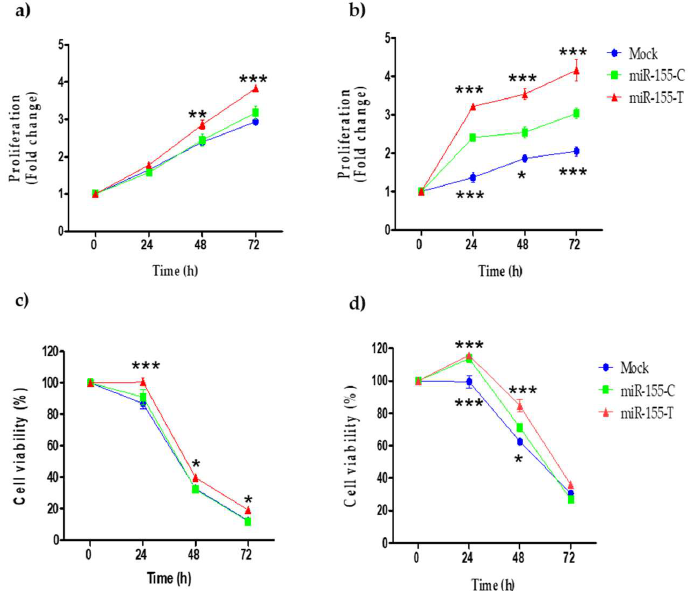
Figure 3. Effect of the miR-155-T allele in proliferation and drug resistance. BC cell lines were transfected with miR-155-C, miR-155-T, or mock vectors, as indicated and grown for 72 h in complete media. Proliferation of MDA-MB-231 ( a ) and MCF-7 ( b ) cells was measured by MTS assay. The graphs show the fold change of absorbance reads at 490 nm at each time. Viability of MDA-MB-231 ( c ) and MCF-7 ( d ) transfected cells upon treatment with 20 μM cisplatin during 72 h. The graphs show the percentages of absorbance reads at 490 nm as compared to time 0. The plotted values indicate the average of three independent experiments ± SD. Significances between the T allele and mock (placed above), as well as between the C allele and mock (placed below), are shown. * p < 0.05; ** p < 0.01; *** p < 0.001. 2.5. The miR-155-T Allele Favors Migration and Expression of EMT-Marker Genes Migration is a fundamental step in the process of metastasis. Therefore, we studied whether the T allele promotes migration in BC cell lines. The results showed that overex- pression of miR-155-T significantly increased the migratory capacity of both cell lines (Fig- ure 4a,b).